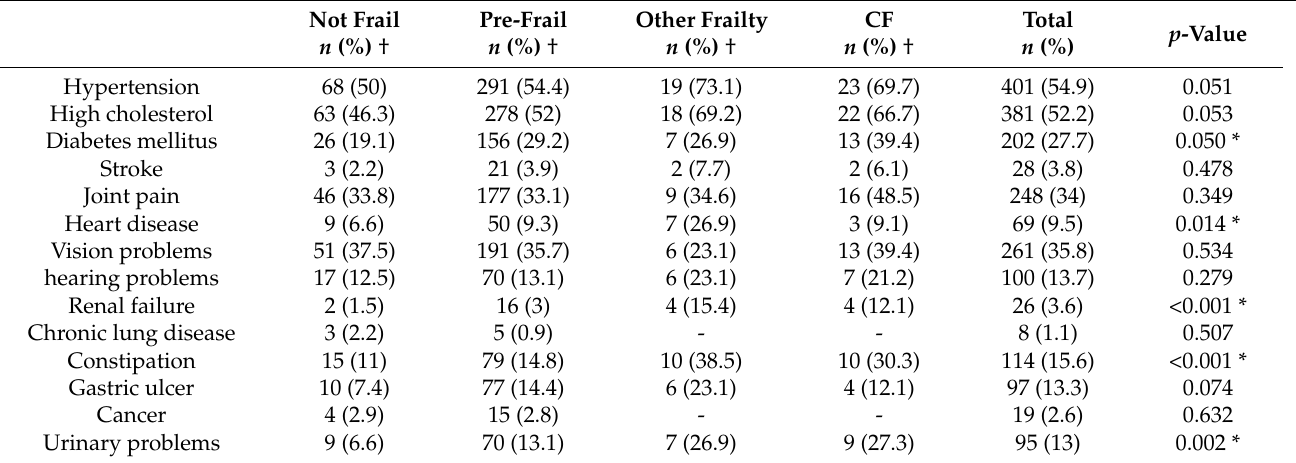
Table 2. Comorbidities Among the Study